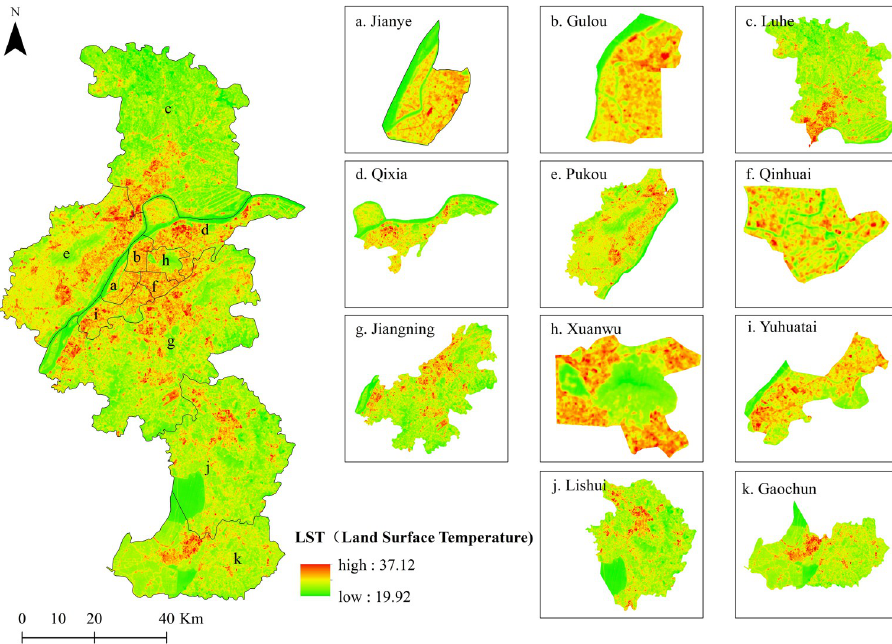
Fig 2. Spatial distribution of LST in Nanjing. The Land surface temperature (LST)of Nanjing city and its districts, (a) Jianye; (b) Gulou; (c) Luhe; (d) Qixia; (e) Pukou; (f) Qinhuai; (g) Jiangning; (h) Xuanwu; (i) Yuhuatai; (j)Lishui;(k) Gaochun. This map is drawn by the authors. This map was created using ArcGIS 1 software by Esri, © National Platform for Common Geospatial Information Services, © OpenStreetMap and contributors, Creative Commons Attribution 4.0(CC BY